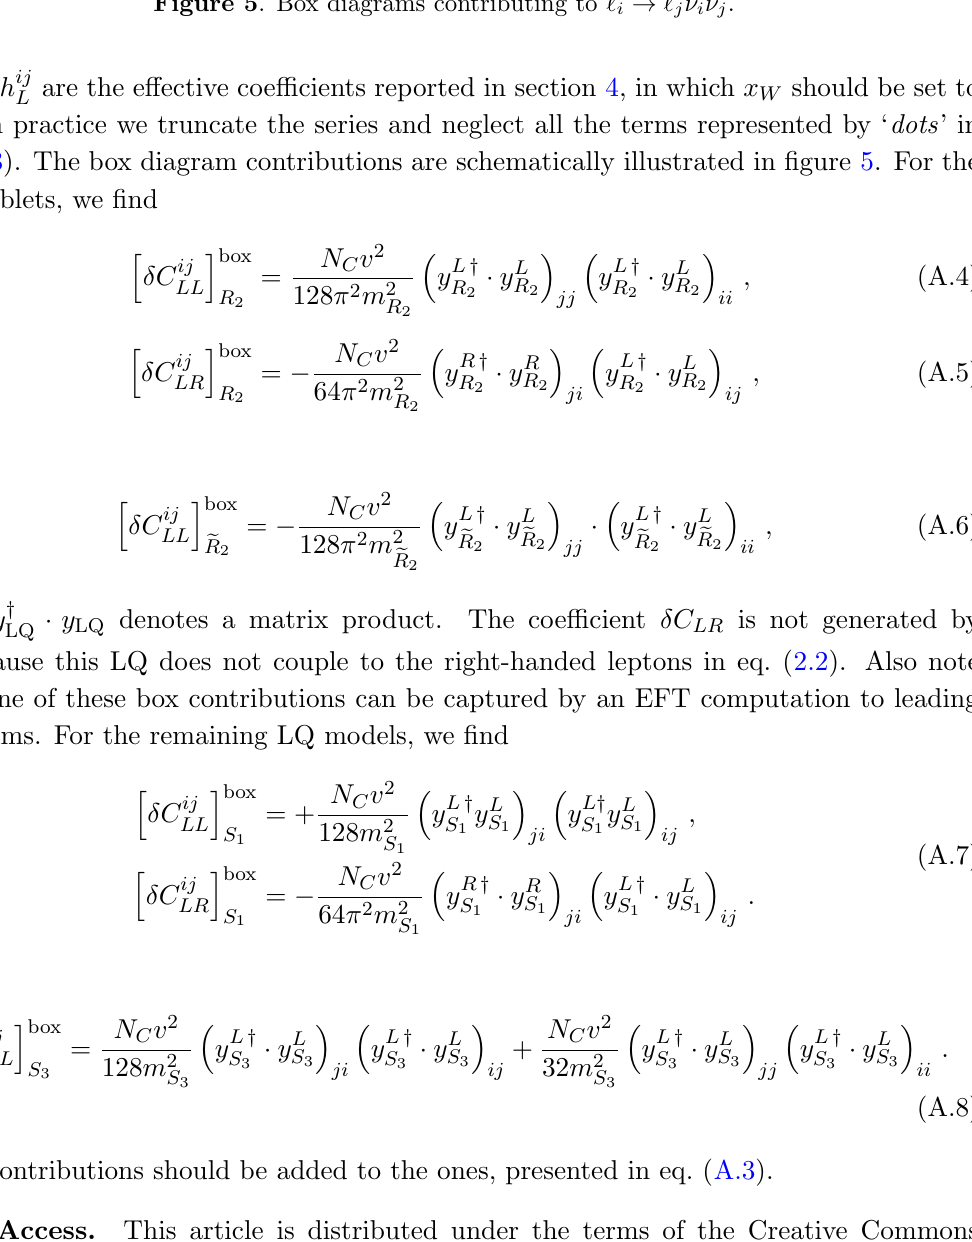
Figure 5 . Box diagrams contributing to ‘ i